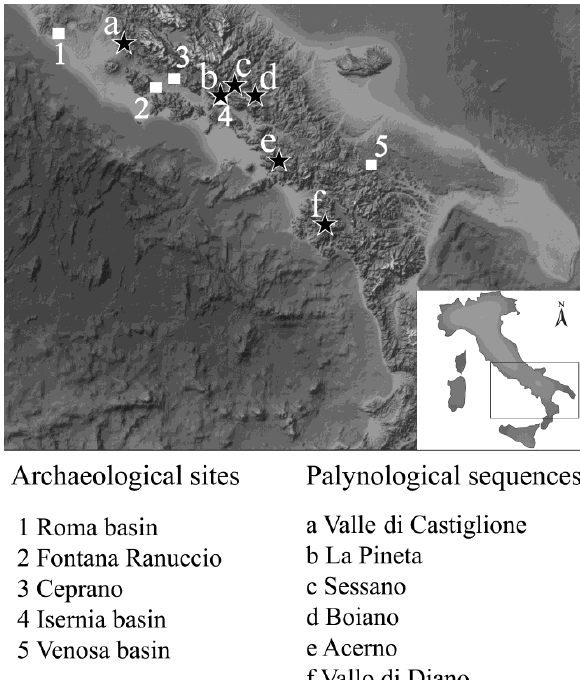
1 Figure 1. Location of the compiled archaeological sites and palynological sequences. 2 3